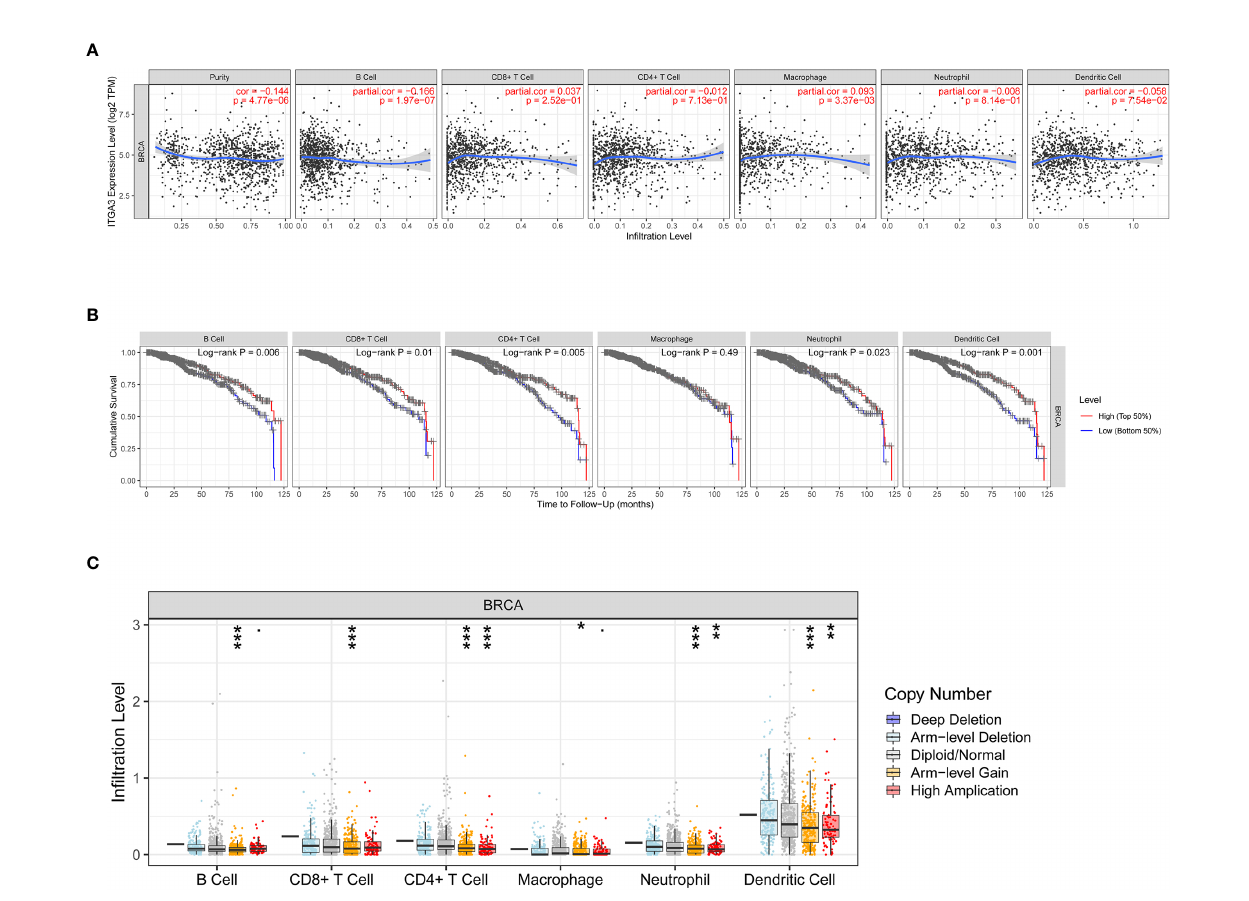
FIGURE 8 | Correlations of ITGA3 with immune in fi ltration level in BRCA. (A) ITGA3 expression is signi fi cantly related to tumor purity and has signi fi cant positive correlations with in fi ltrating levels of macrophages, and signi fi cant negative correlations with in fi ltrating levels of B cells in LIHC. (B) Kaplan – Meier plots of immune in fi ltration and ITGA3 expression level in BRCA. (C) ITGA3 CNV affects the in fi ltrating levels of immune cells in BRCA. (P-value Signi fi cant Codes: 0 ≤ *** < 0.001 ≤ ** < 0.01 ≤ * < 0.05 ≤ . <